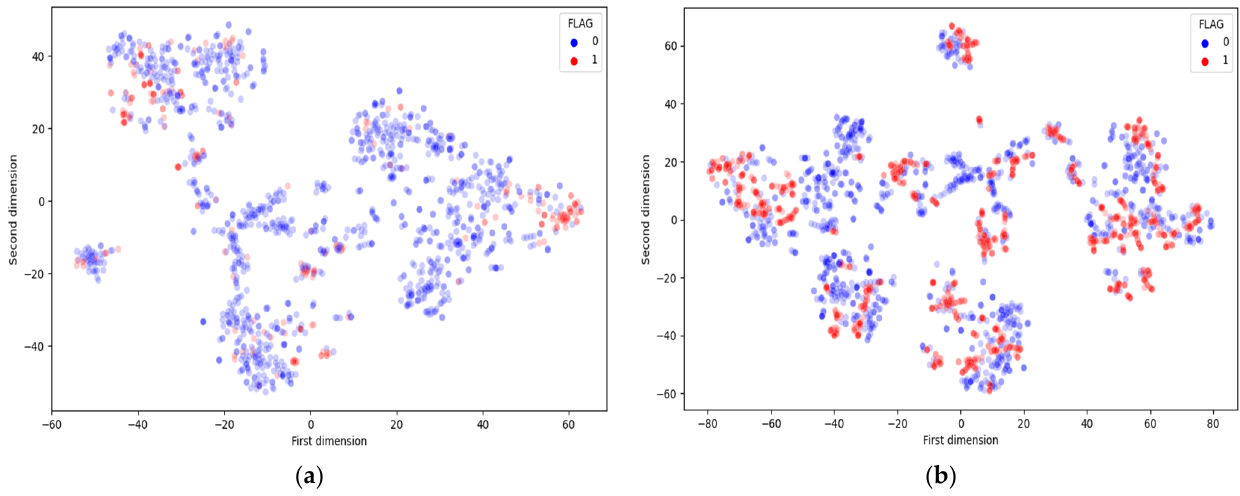
Figure 4. Two-dimensional scatter plot following t-SNE transformation concerning contract label. Red and blue data points clarify the abnormal and normal contracts, respectively, in ( a ) original and ( b ) oversampled training data.